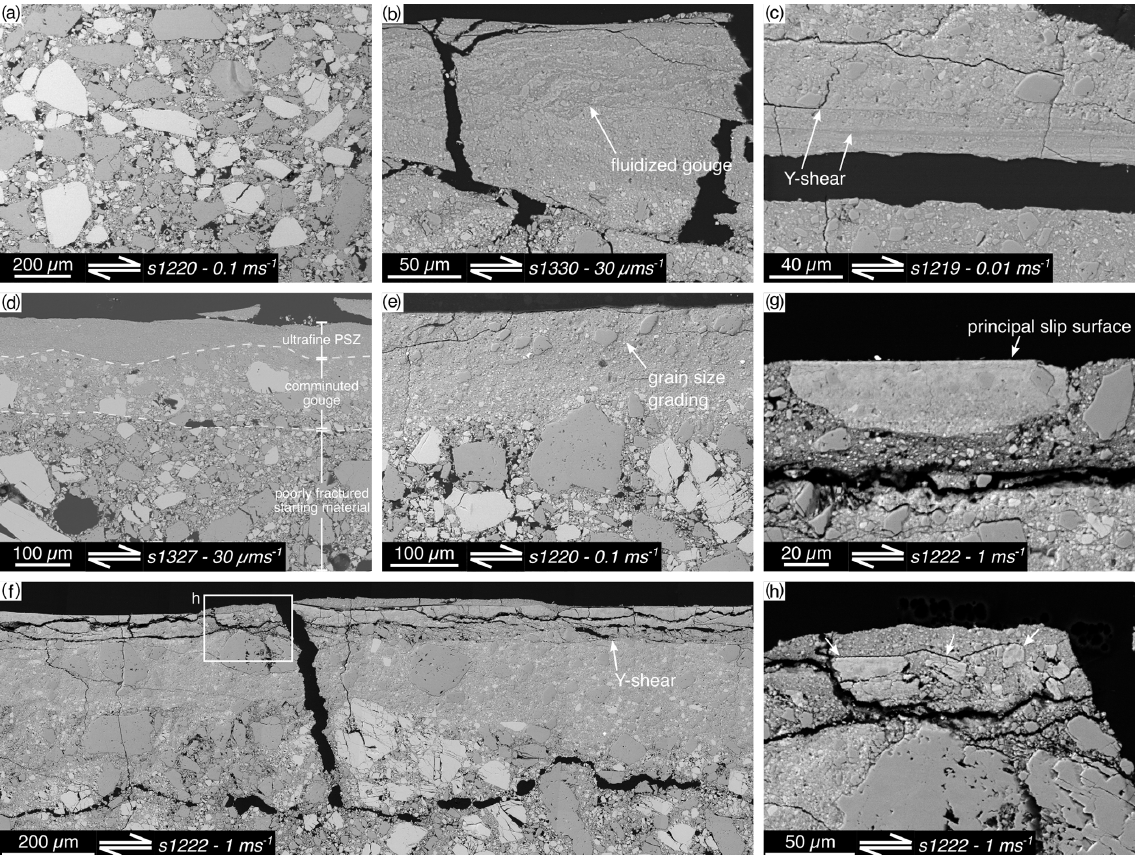
Figure 10. Microstructures of experiments in water-dampened conditions. (a) The bulk gouge is made of a poorly fractured calcite and dolomite mixture highly resembling the starting material. (b) Occurrence of fluidised structures in the principal slip zone of experiments performed at 30µms − 1 . (c) At 0.0001ms − 1 ≤ V < 0.1ms − 1 , the principal slip zone is cut by multiple Y shears. (d) In the presence of fluid water, an ultrafine principal slip surface develops, overlying a highly comminuted gouge which then transitions to a poorly fractured starting material. (e) At V = 0 . 1ms − 1 , grain size grading is observed in the principal slip zone, with larger clasts occurring near the principal slip surface. (f) At V = 1ms − 1 , strain localises on a compacted, low-porosity, recrystallised slip zone, which (g) is not continuous and (h) often found broken and